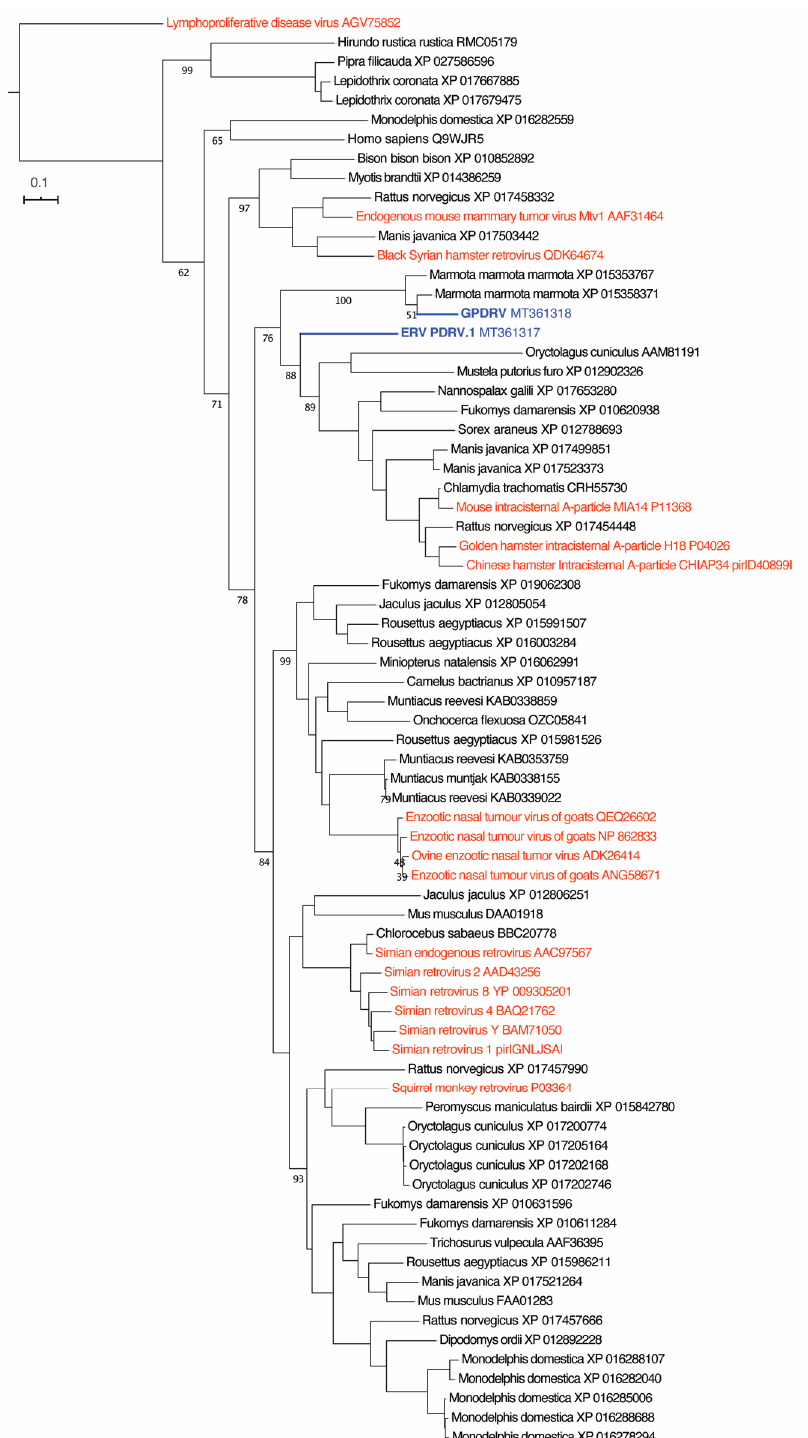
Figure 5. GPDRV is most closely related to retroviral-like sequences in the marmot genome. A tree was made from the sequences in the NCBI protein database most closely related to GPDRV Pol as determined by a BLASTP search. The Felsenstein bootstrap (FBP) support values of select branches are indicated. The GPDRV and GPD ERV Pol sequences are colored blue. Sequences annotated as belonging to the Retroviridae family are colored red. The rest of the sequences are annotated as belonging to the indicated mammalian species and are present in the corresponding genome assemblies. The tree was rooted using lymphoproliferative disease virus Pol, which was included as an outgroup.